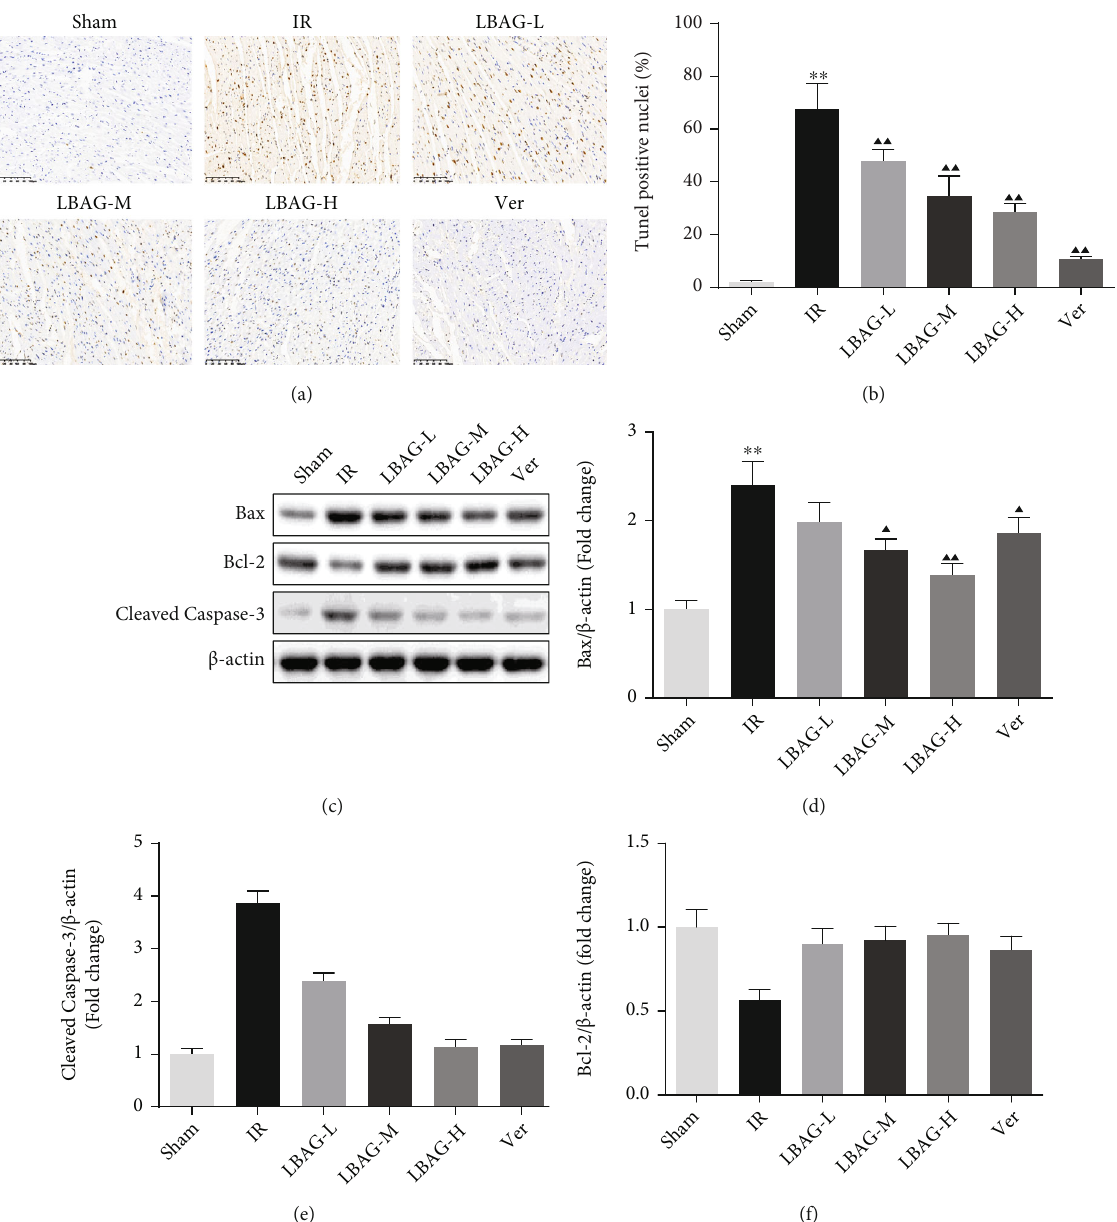
Figure 4: E ff ect of LBAG on cardiomyocyte apoptosis in rats. (a) Cardiac apoptosis was assessed by TUNEL staining (magni fi cation, × 200). (b) Positive apoptosis cells in each group. (c) Western blot analysis and statistical analysis of (d) Bax, (e) cleaved caspase-3, and (f) Bcl-2 proteins in each group. ∗ P < 0 : 05 and ∗∗ P < 0 : 01 vs. sham group. ▲ P < 0 : 05 and ▲▲ P < 0 : 01 vs. IR